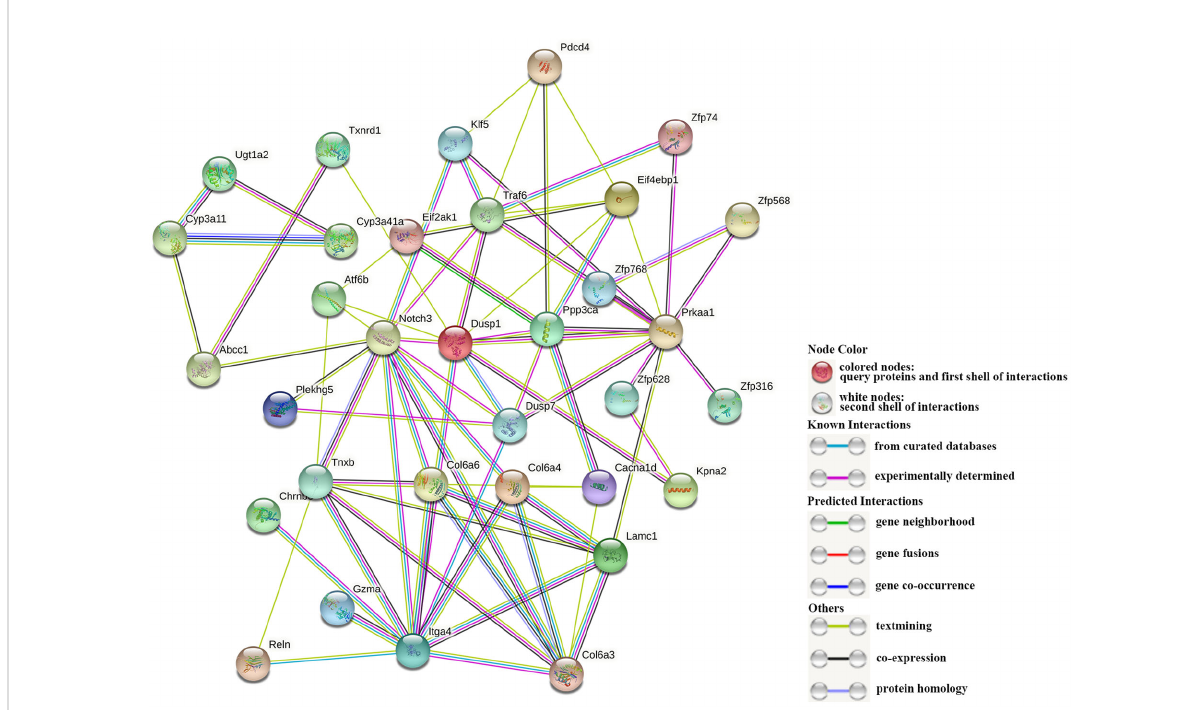
FIGURE 6 The interaction of DEGs. Each dot represents a protein, and their names are shown next to them. The different lines between dots represent different